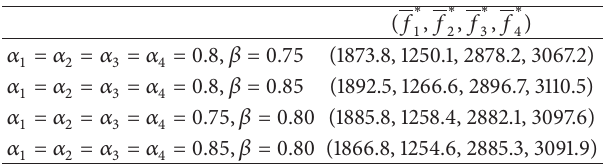
Table 5: Sensitivity